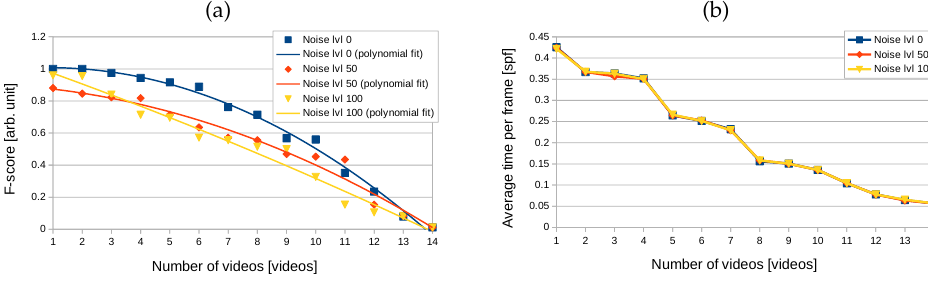
Figure 16. ( a ) Comparison of F-score survival curves between different levels of noise. ( b ) Comparison of average time per frame survival curves between different levels of